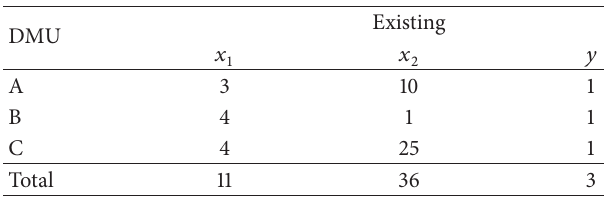
Table 1: The data related to the three DMUs.